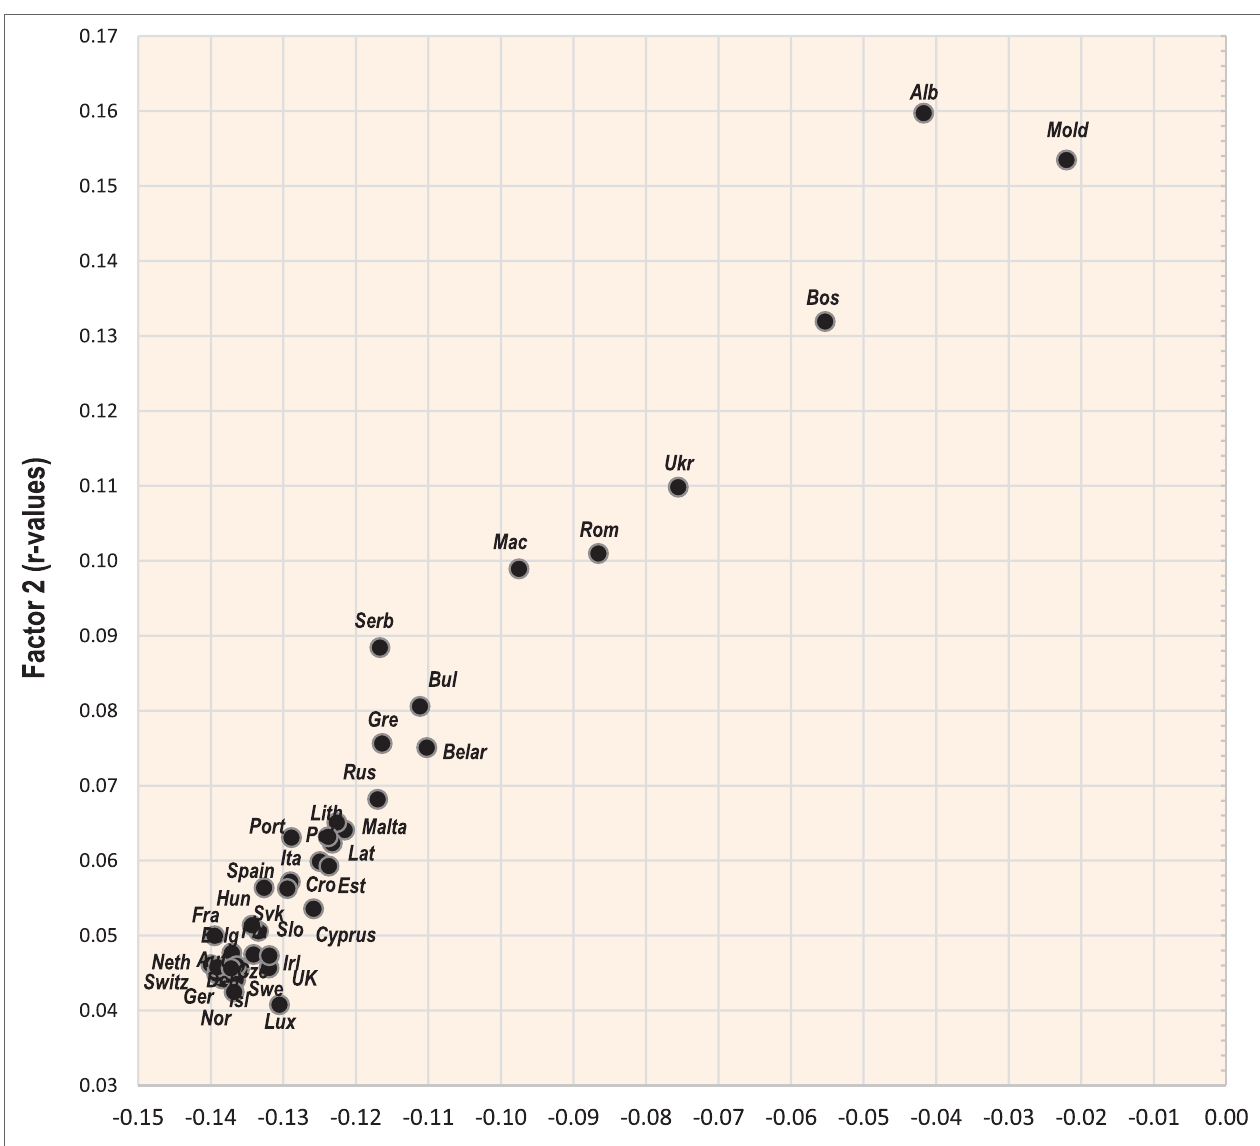
FigUre 8 | Projection of 39 countries on the factor plane of Figure 7